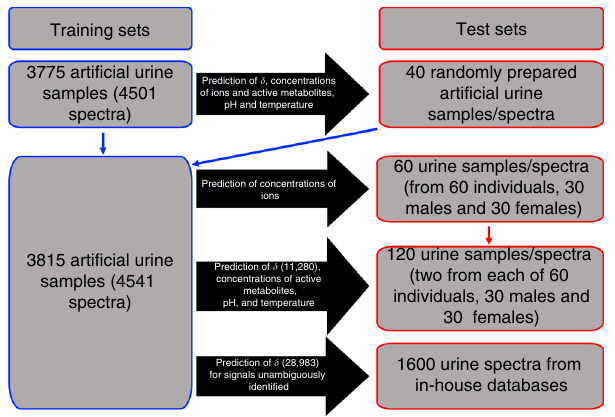
Fig. 2 Schematic summary of arti fi cial and real urine samples and spectra used for training and test of the predictor. Initially, 3775 arti fi cial urine samples were prepared and their spectra recorded at 300 K. For a subset of 726 samples, selected among those exhibiting high diversity of metabolite concentrations, spectra were also recorded at 302.7 K. These samples/ spectra were used to build the predictor (Supplementary Data 1; Supplementary Note 1). The predictor was tested on an independent set of 40 spectra of randomly prepared arti fi cial urine samples. The training of the predictor was repeated by including the 40 additional samples/spectra. An independent set of 120 samples of real urine from 60 individuals was collected and their spectra used as the test set for the predictor (Supplementary Data 3). For 60 of these samples, the concentrations of 11 inorganic ions was independently measured by analytical/clinical methods and used to test the prediction of ion concentrations. Finally, another independent set of 1600 urine spectra 17 – 19 was used to test the prediction of 28,983 δ values (Supplementary Data